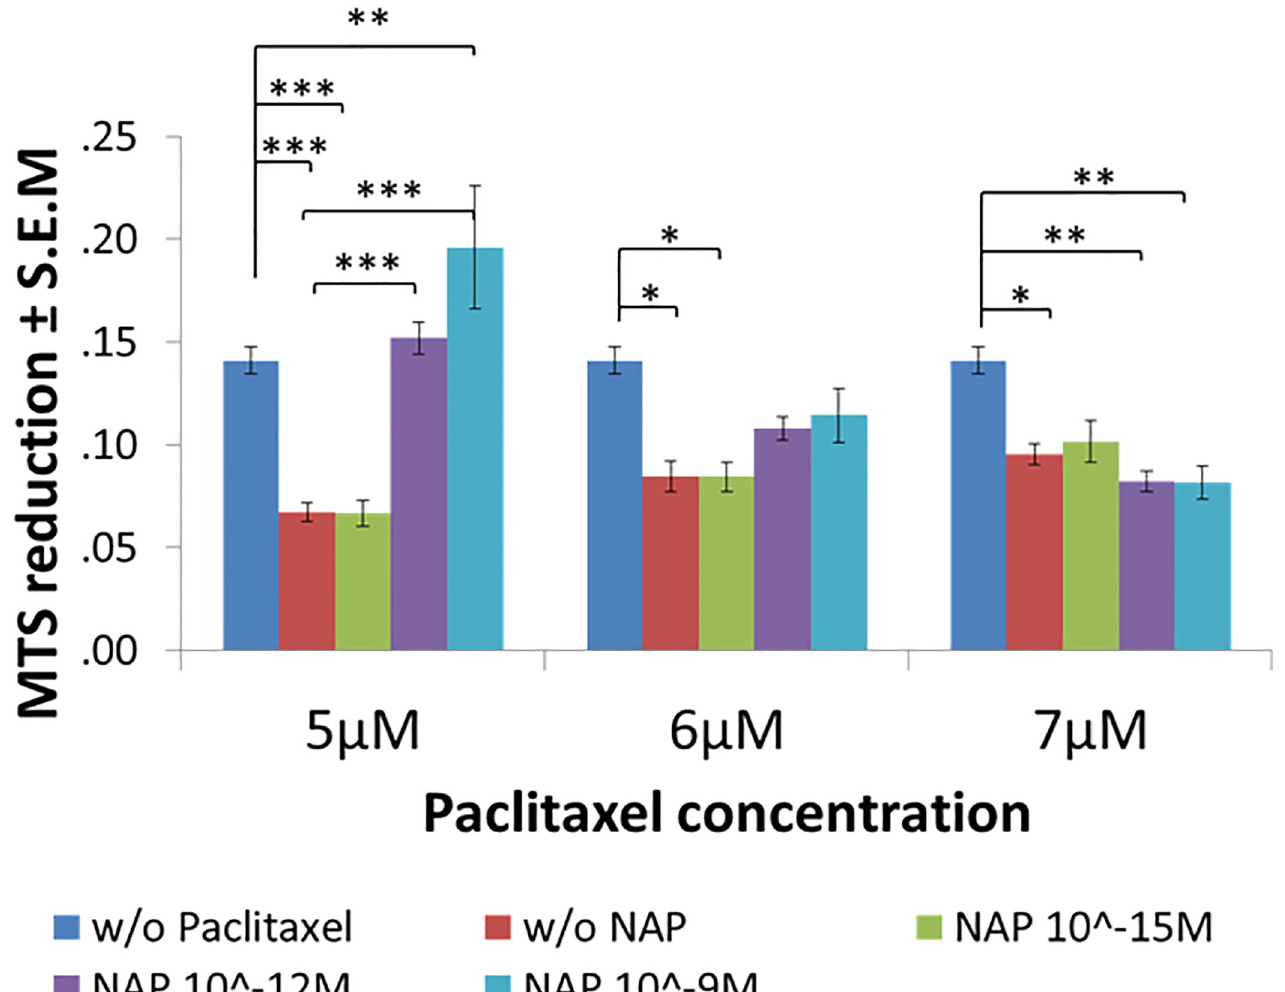
Fig 4. NAP protective activity is inhibited by paclitaxel. Cell viability test performed by the MTS assay (measures mitochondrial activity, see “Materials and Methods”). Differentiated N1E-115 cells are exposed to different concentrations of NAP (10 -15 M, 10 -12 M, 10 -9 M) and paclitaxel (5, 6 and 7 μ M) for 2 hrs. Average of mitochondrial activity results (MTS reduction) are displayed in relation to the control (non-treated cell) value– 0.1411 ± 0.02989. Statistical analysis of the data was performed using one-way ANOVA with Tukey post hoc test, n = 5. Statistical significance is presented relative to control as � P < 0.05, �� P < 0.01, ��� P < 0.001; to “w/o NAP” (cells treated with paclitaxel, alone) as #P < 0.05, ##P < 0.01, ###P < 0.001.